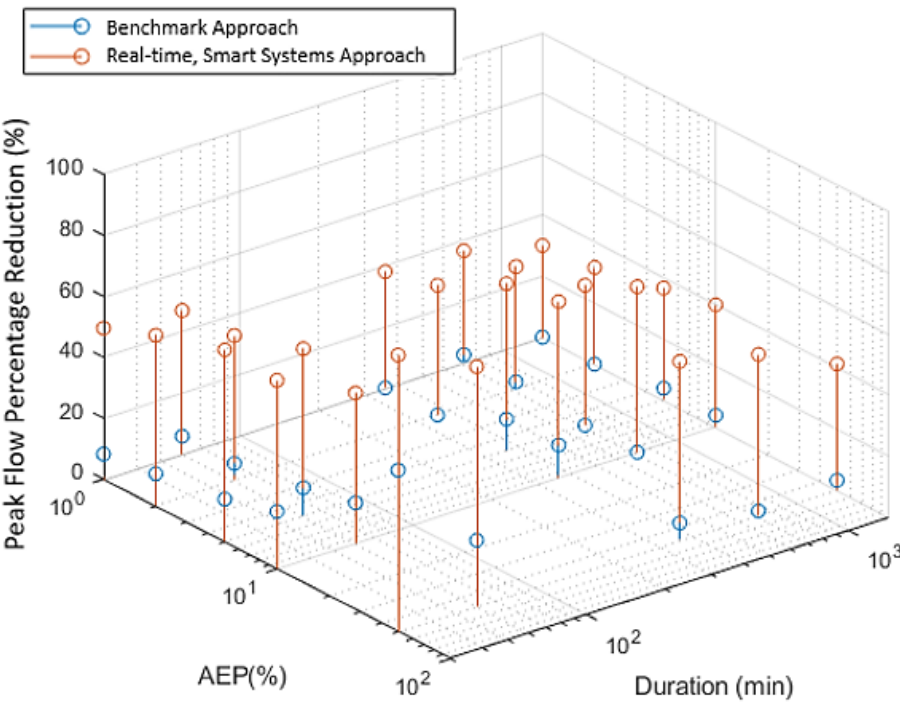
Figure A3. Percentage peak flow reduction of benchmark tanks and real-time, smart tank systems for a range of durations and AEPs with 2 × 2 m 3 tanks in Melbourne.